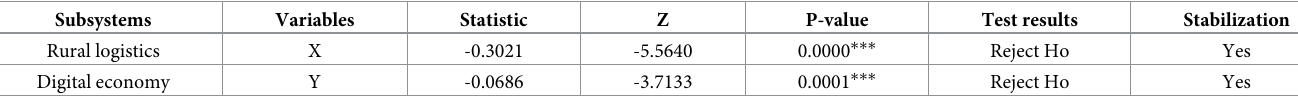
Table 7. Harris-Tzavalis unit-root test for Y and